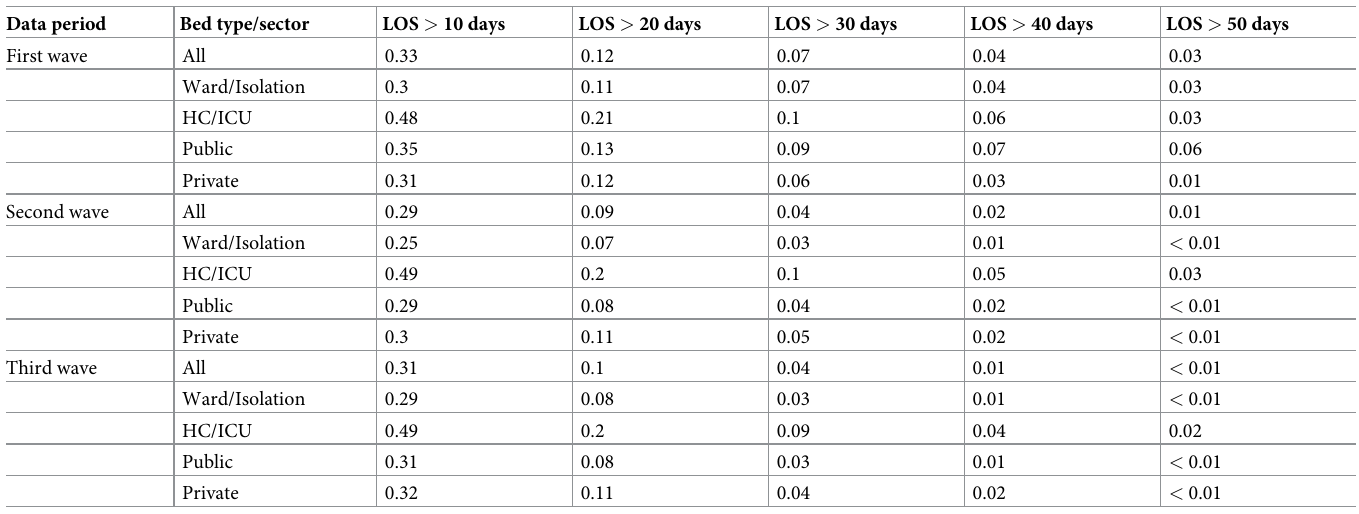
Table 2. Proportion of long hospital